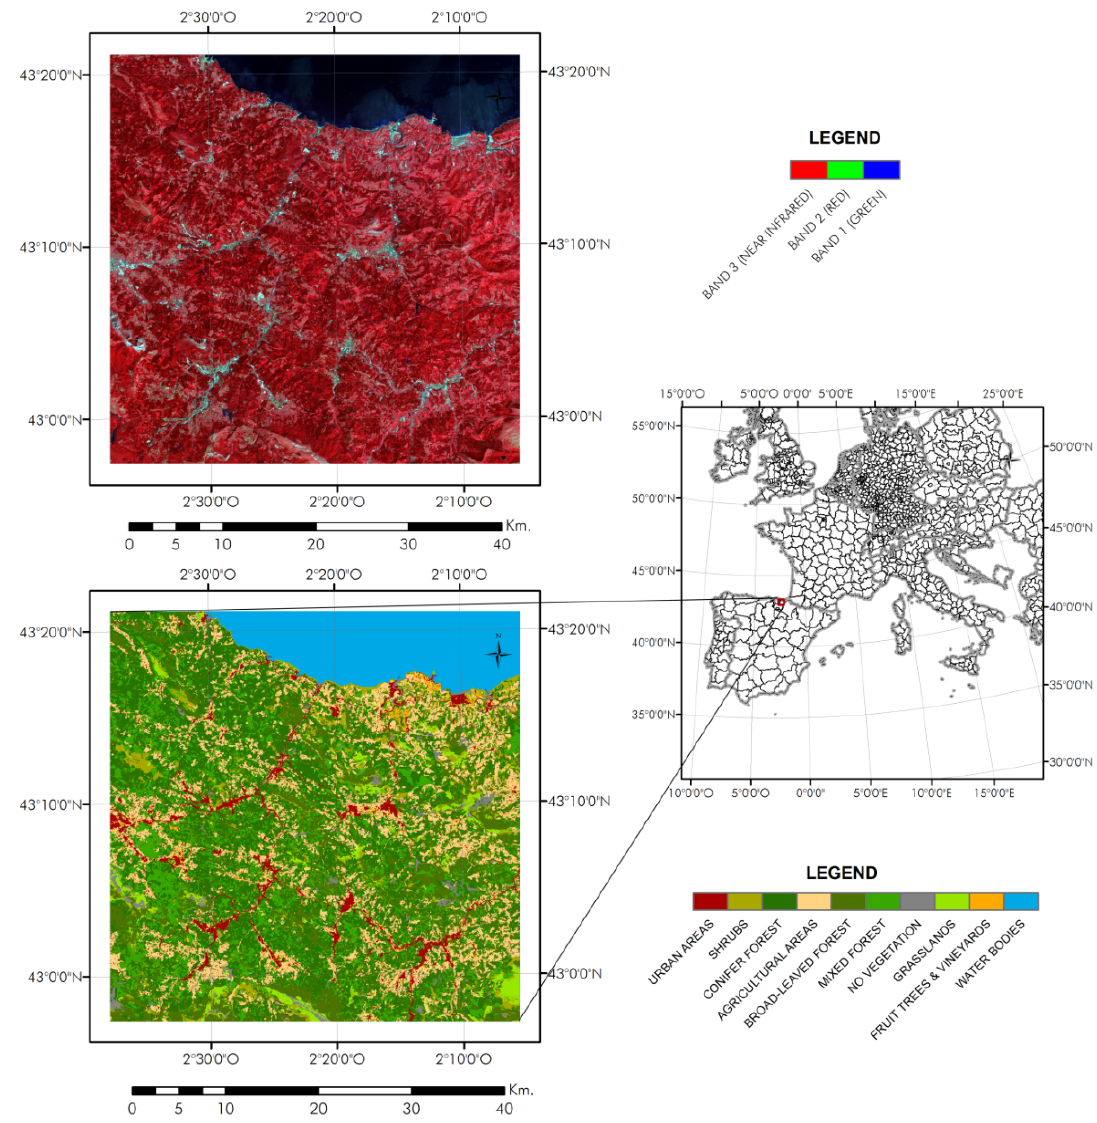
Figure 1. Land cover information (level 3) and SPOT 5 scene of the study site.